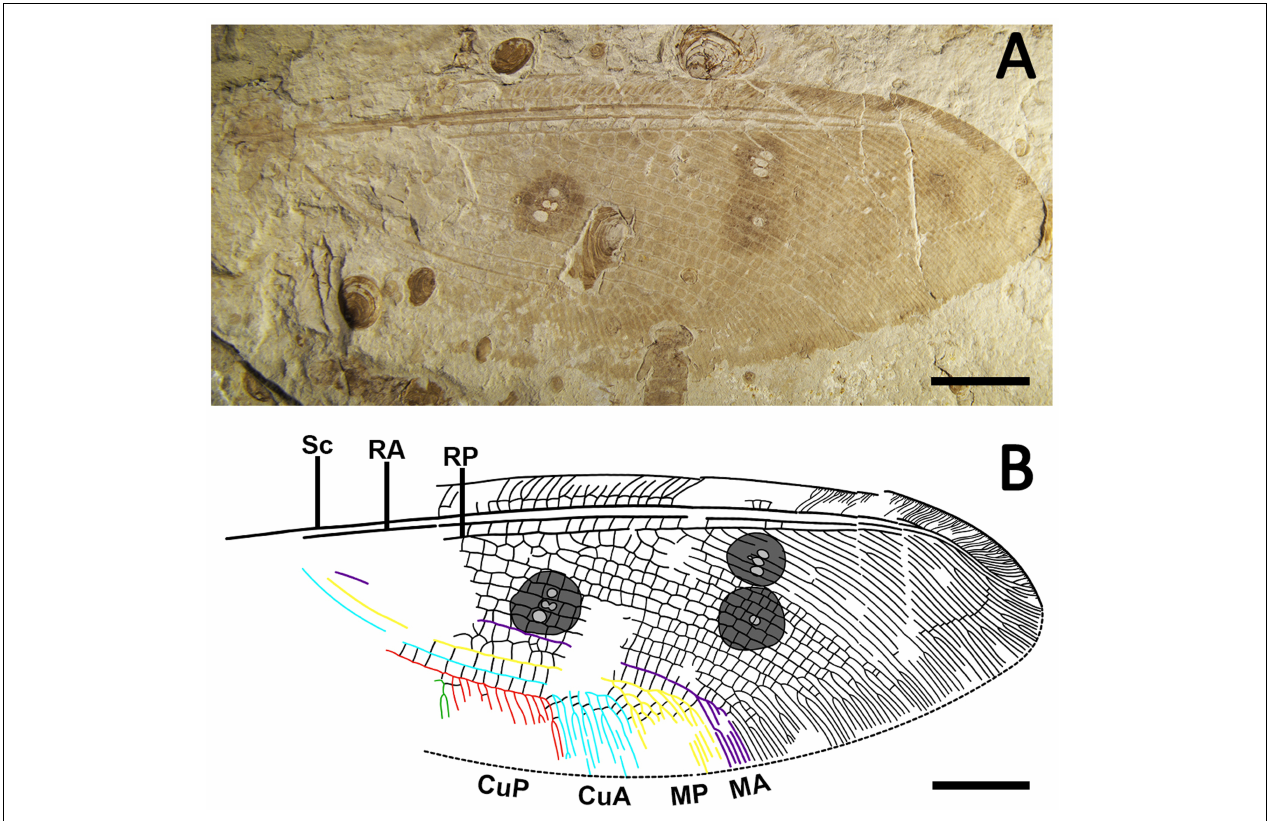
FIGURE 1 | Lance lacewing Arbusella platyptera Ma and Wang, sp. nov. (holotype, CNU-NEU-NN2020005) from the Middle Jurassic of Jiulongshan Formation in Daohugou, China. (A) Photograph of the hind wing. (B) Line drawing of the hind wing. Scale bars are 10